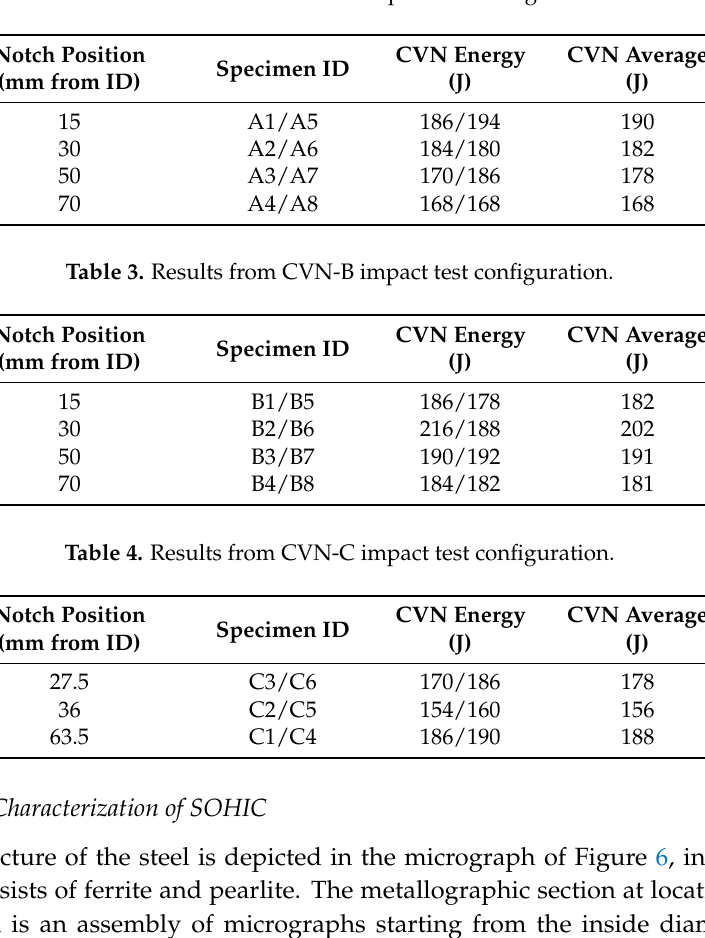
Table 2. Results from CVN-A impact test configuration.